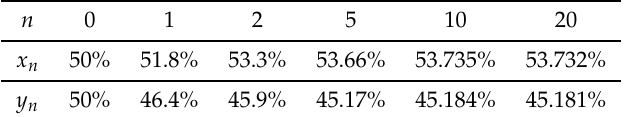
Table 11. Values of the iterated sequence ( x n , y n ) if started with ( 50%,50% ) . n